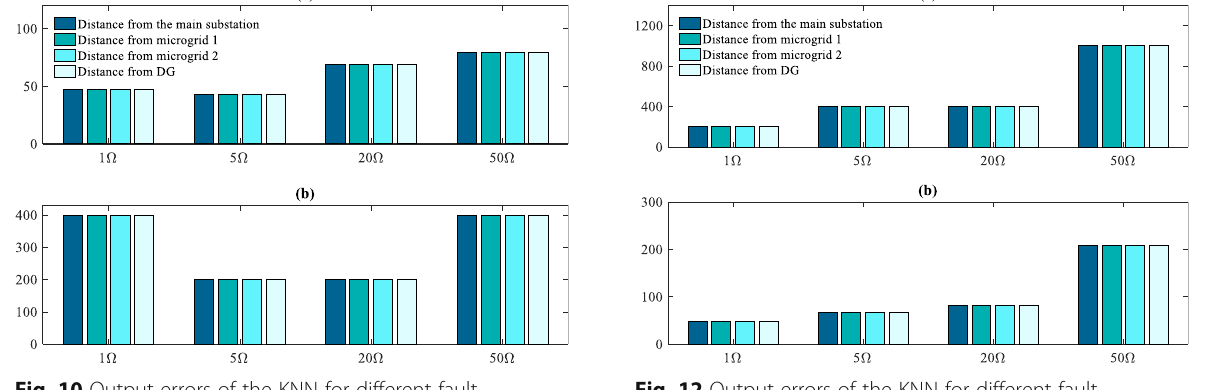
Fig. 10 Output errors of the KNN for different fault resistances for 424 test cases. a RMSE b MAE